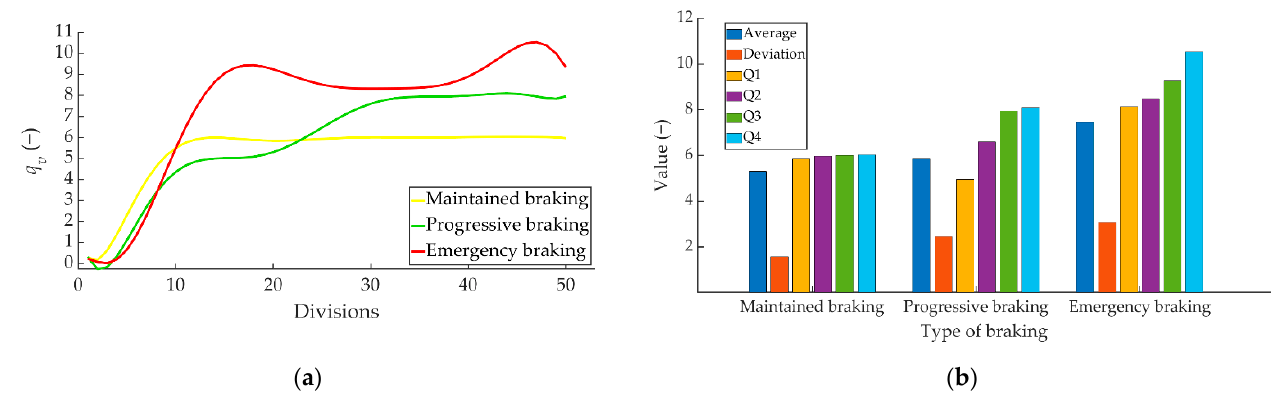
Figure 11. Example of the three types of braking at 80 km/h performed by one of the drivers ( a ) q v and ( b ) statistical